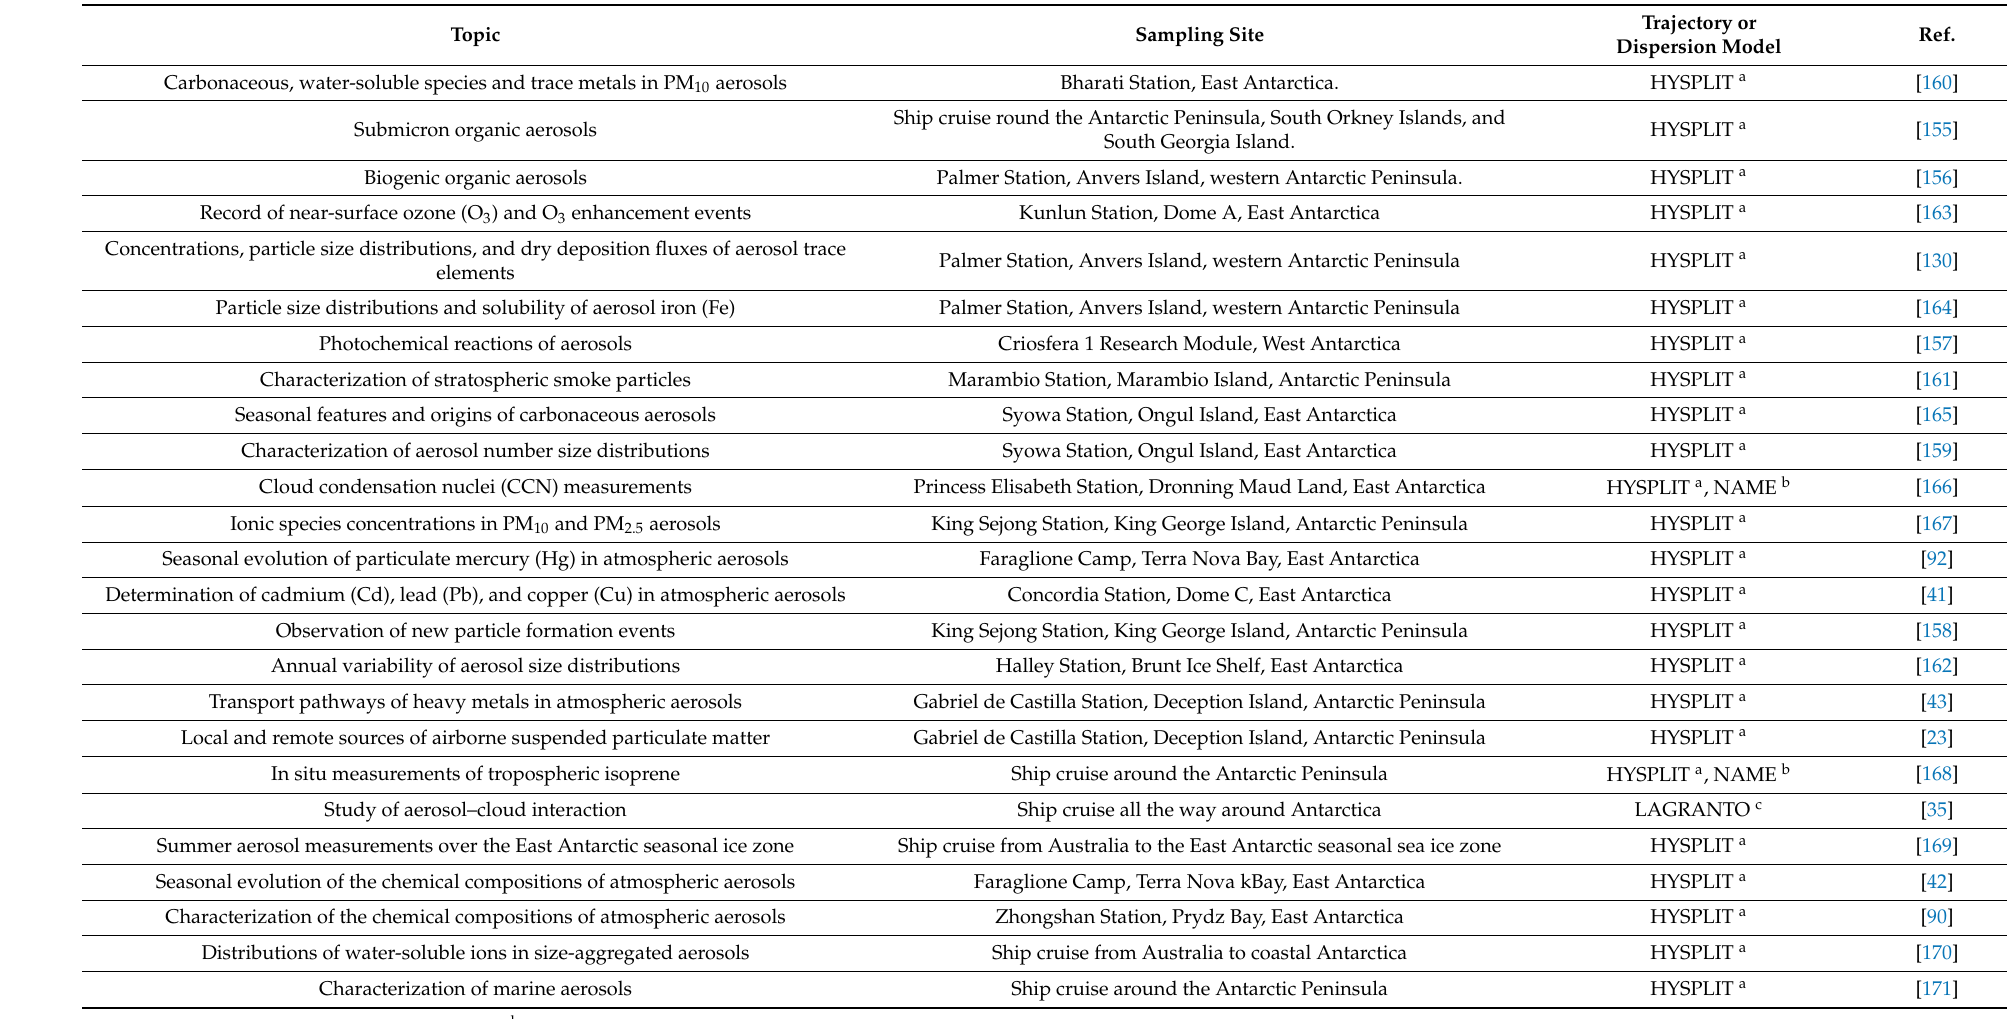
Table 4. Compilation of recent studies on atmospheric aerosols in the Antarctic region that use back trajectories or dispersion models. Topic Sampling